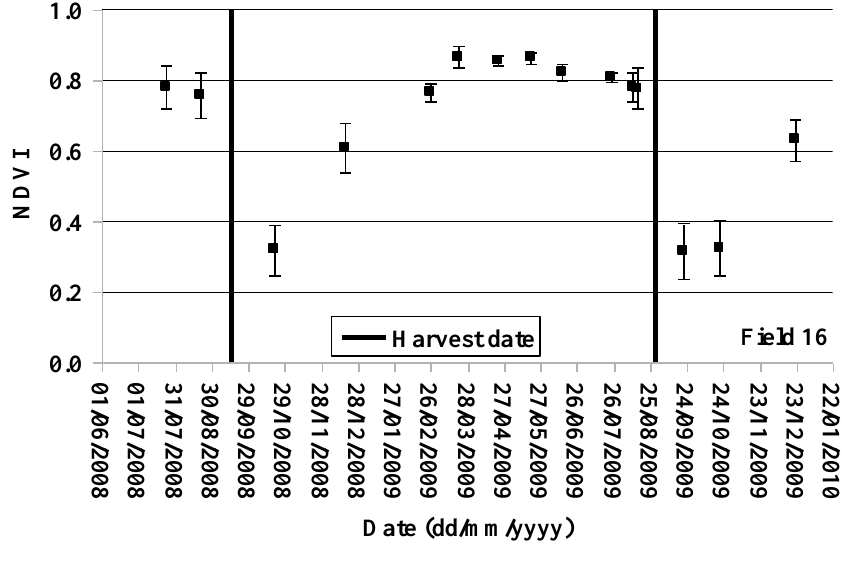
September 01, 2008 and August 29, 2009. The error bars correspond to the standard deviation of